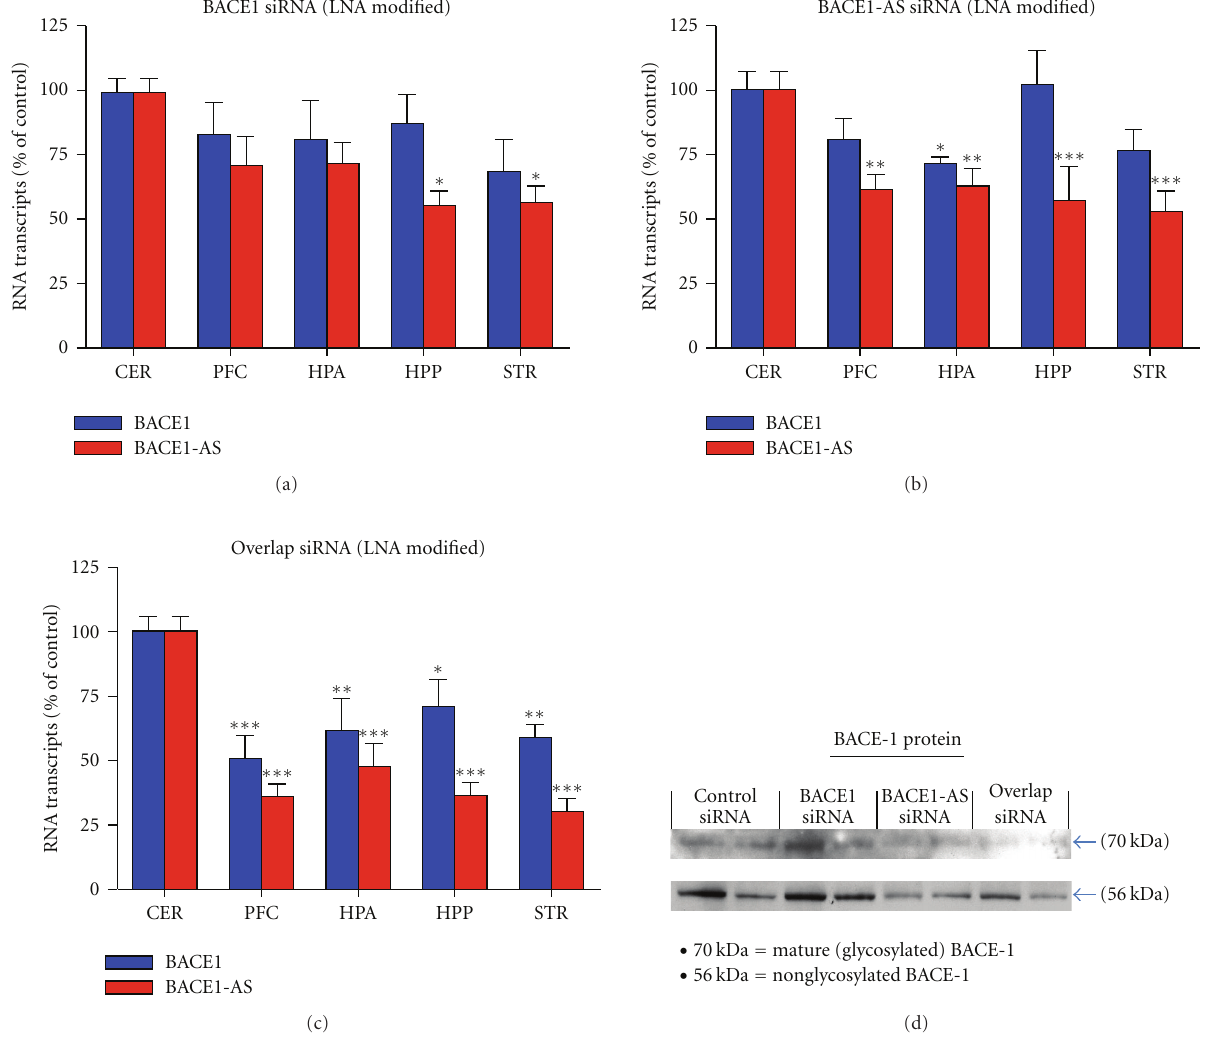
Figure 5: E ff ects of siLNA in BACE1 and BACE1-AS RNAs levels in vivo . To test the ability of siLNAs to a ff ect BACE1 and BACE1-AS in vivo , we inserted a minipump as explained with overlap siLNA (a), BACE1-AS siLNA (b), and BACE1 siLNA (c) during two weeks. LNA-modified siRNAs reduced BACE1 mRNA levels in approximately 60% in each of the brain regions examined. In hippocampus, the protein levels of BACE1 were also clearly reduced (d,